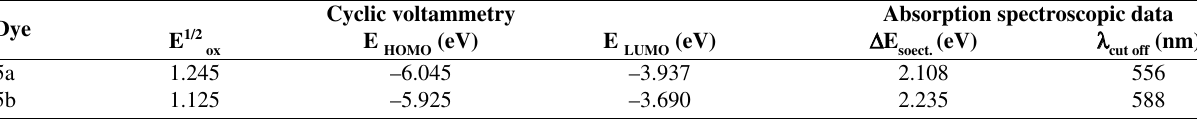
Table 1 . Electrochemical and spectroscopic analysis data of the synthesized dyes 5a and 5b Cyclic Dye